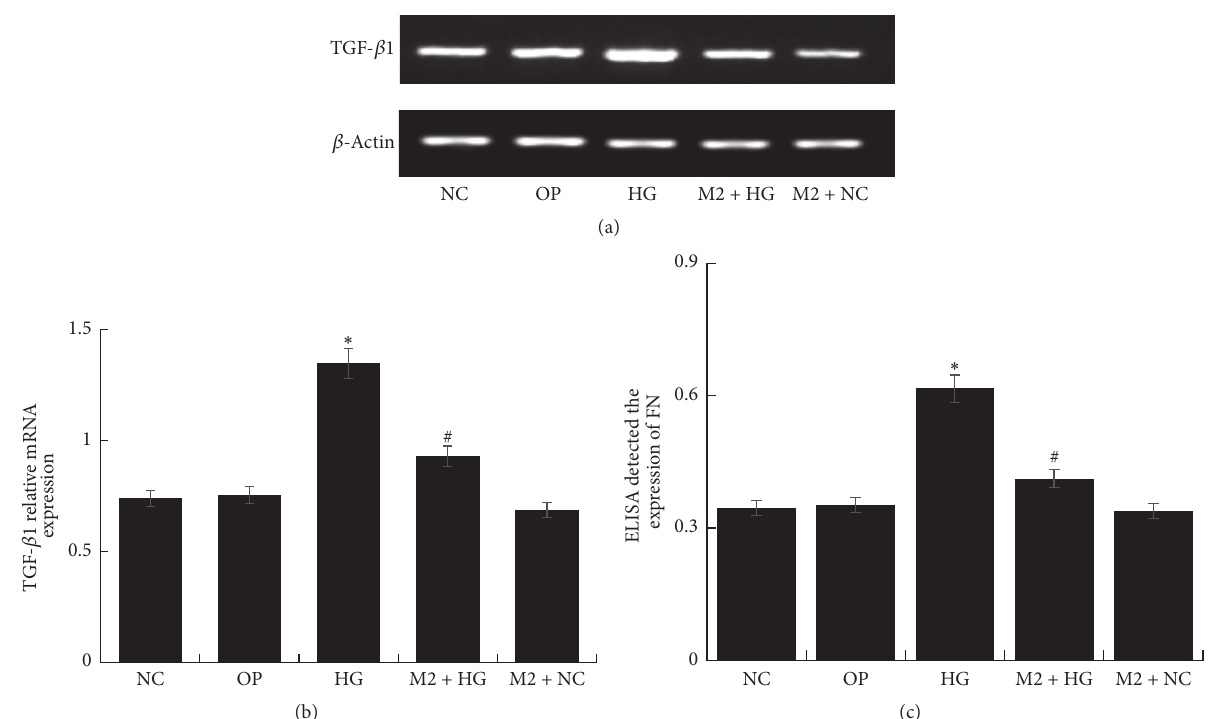
Figure 8: The level of TGF- 𝛽 1 and FN in each group. (a) RT-PCR detected the expression of TGF- 𝛽 1 mRNA after the treatment of maresin 1 for 48 h; compared with HG group, TGF- 𝛽 1 mRNA was significantly decreased in M2 + HG group. (b) The corresponding relative gray value statistics graph of the mRNA level. ∗ 𝑃 < 0.05 versus NC group, # 𝑃 < 0.05 versus HG group. (c) FN ELISA kit detected the level of FN in supernatant of GMCs after the treatment of maresin 1; ∗ 𝑃 < 0.05 versus NC group, # 𝑃 < 0.05 versus HG